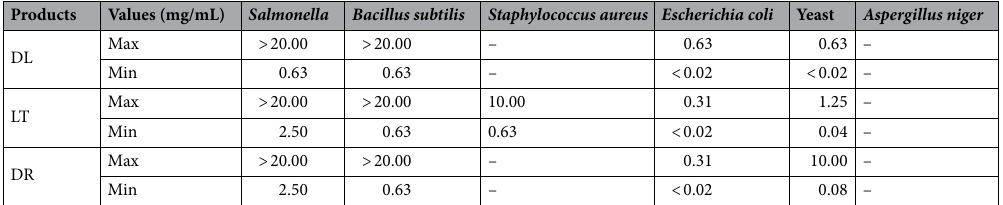
Table 6. Maximum (Max) and minimum (Min) inhibition concentrations of three products from Astragalus membranaceus (Fisch.) Bge. to six tested microbial strains. DL, dry leaves; LT, leaf tea; DR, dry roots. “–” indicates no inhibition detected in the test. “ < ” means less than a value, and “ > ” means more than a